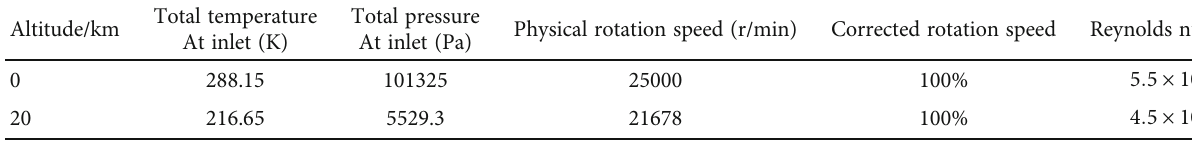
Figure 1: Computational grid structures in local domain of the compressor. Table 2: Numerical parameters of the simulation at di ff erent altitudes.